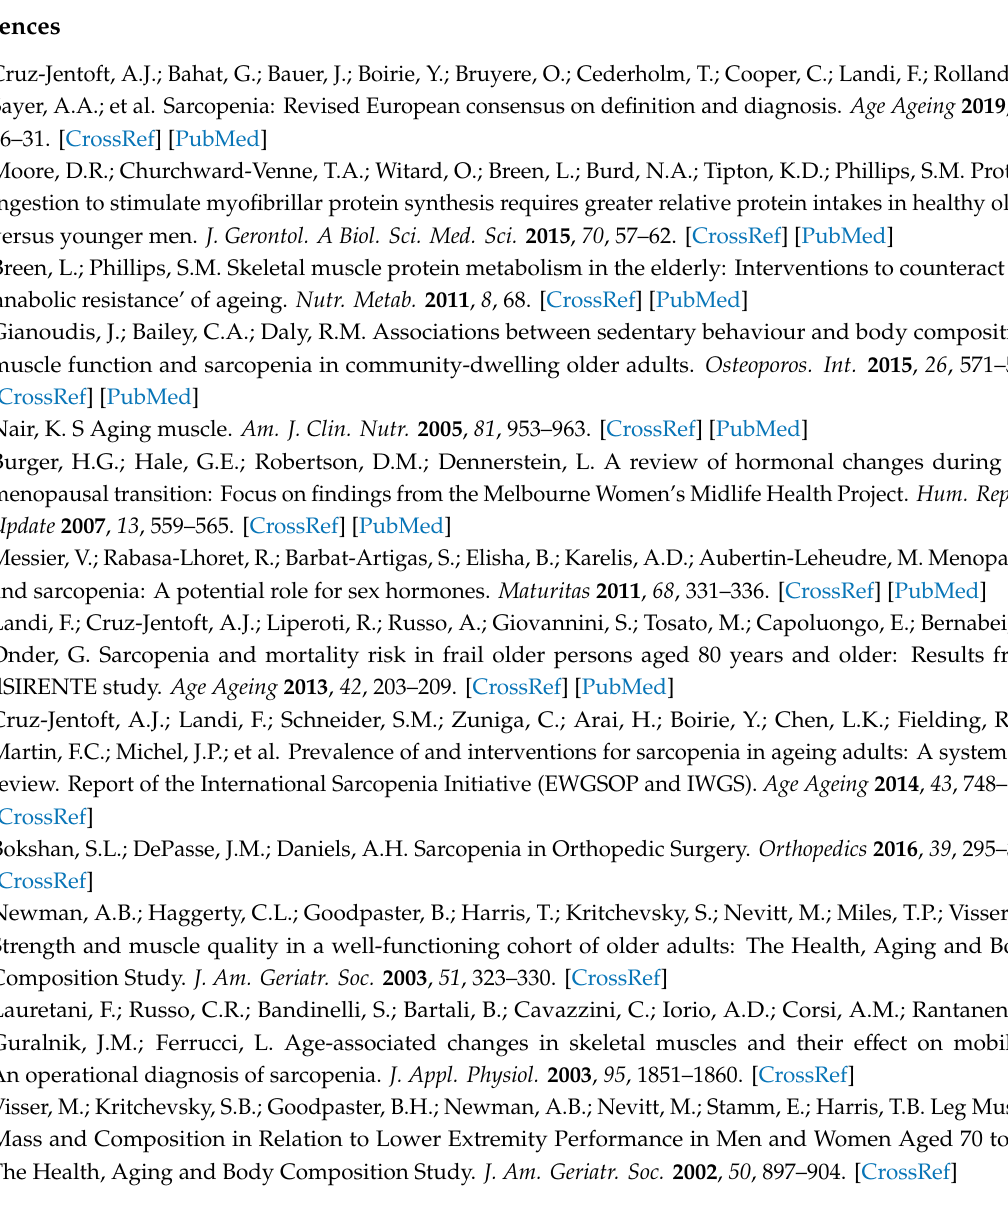
Table S1: Strength, functional capacity and lean mass quality values according to moments and groups, without multiple imputation